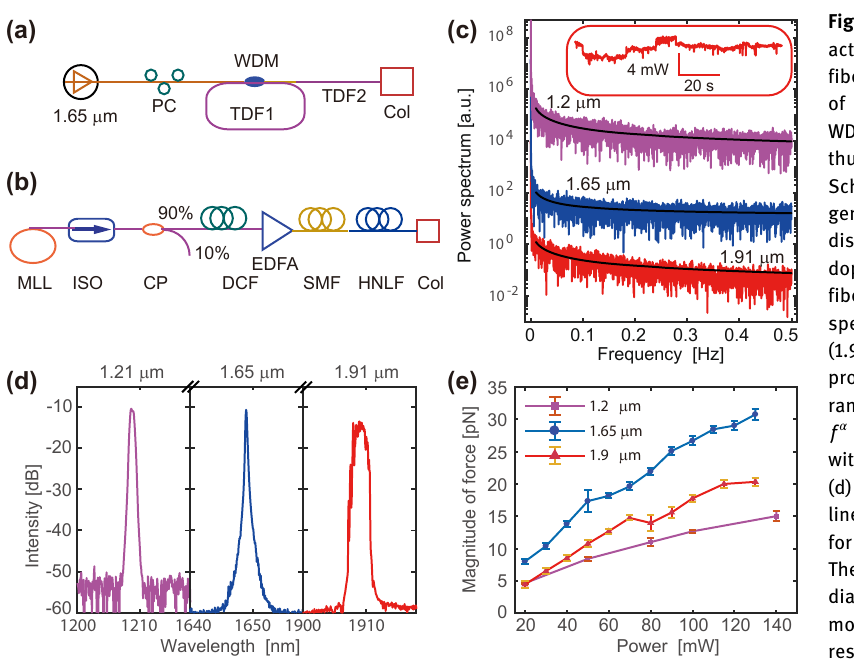
Figure 3: Schematic of the multi-line back- action force. (a) The layout for a custom-built fiber laser operating at a central wavelength of 1.91 μ m. PC, polarization controller; WDM, wavelength division multiplexer; TDF, thulium-doped fiber; Col, collimator. (b) Schematic layout for the supercontinuum generation. ISO, isolator; CP, coupler; DCF, dispersioncompensatingfiber;EDFA,erbium doped fiber amplifier; SMF, single mode fiber; HNLF, high nonlinear fiber. (c) Power spectrum of the 2-stage TDF fiber laser (1.91 μ m wavelength, red curve) suggests pronouncednoiseatextremelylowfrequency range. The power spectrum approximates an f 𝛼 noise. Inset shows the power fluctuation with respect to time for the TDF laser. (d) The optical spectra of the three laser lines operating at continuous wave used for the backaction force experiment. (e) The magnitude of optical force on 10 μ m diameter polystyrene microsphere increases monotonically with the laser power for the respective laser lines. laser with both low and high coherence can be used to pull the dielectric spheres towards the light source. The custom-built all-fiber laser centered at 1.91 μ m with a much broader spectrum as compared with the commercial Raman lasers (Figure 3(d)) can also pull the microspheres towards the light source. This PNJ mediated force not only takes place with pulsed laser, but also appears with laser under continuous wave operation. The laser lines with apparent particle backaction are within the near-/mid-infrared region, for which the water absorption is much greater than the visible wavelength. Both the Raman lasers with wavelength 1.21 and 1.65 μ m provide backaction force on the polystyrene microsphere. The magnitude of force with 1.65 μ m laser is stronger than the laser with 1.21 μ m wavelength at the same injected laser power. To mention that the light absorption in the dielectric suspension is strong at these wavelengths; such backaction was not observed with light in the visible range operating in continuous wave.